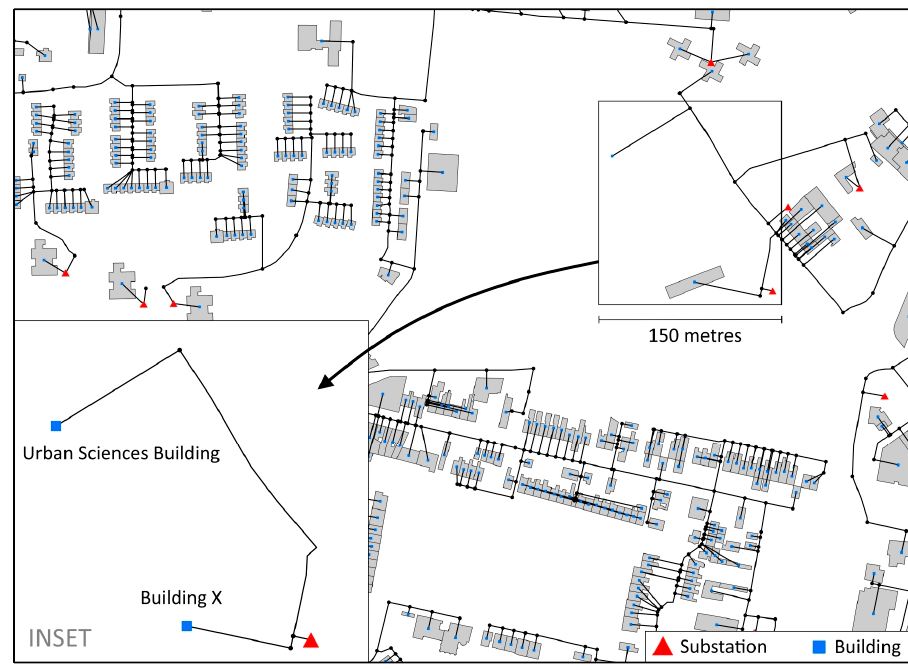
Figure 2. Heuristically derived electricity distribution feeder networks for an area of the city of Newcastle upon Tyne, UK. The inset zooms in on a single, small distribution feeder network (located in the top ‐ right of the figure) that is used as the subject network for this study. Contains OS data © Crown copyright and database right ( 2018).